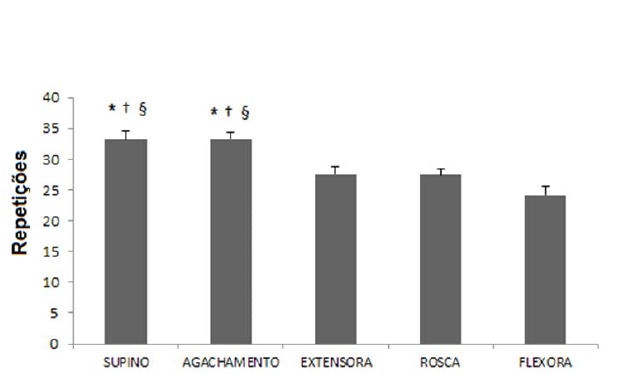
Figura 1. Somatório do número de repetições em cada exercício (n = 17). Valores em média e erro padrão. * p < 0,05 vs. rosca direta. † p < 0,05 vs. cadeira extensora. § p < 0,05 vs. mesa flexora.